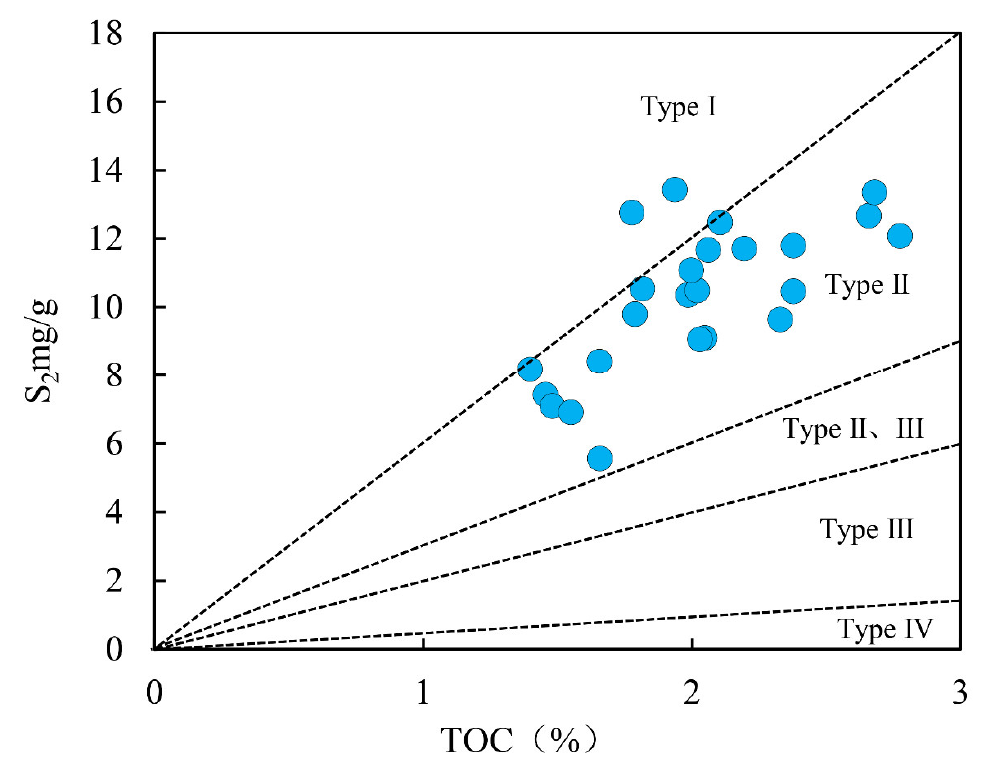
Figure 6. Diagram of S 2 vs. TOC, indicating types I and II organic matter of the Qingshankou lacus- trine